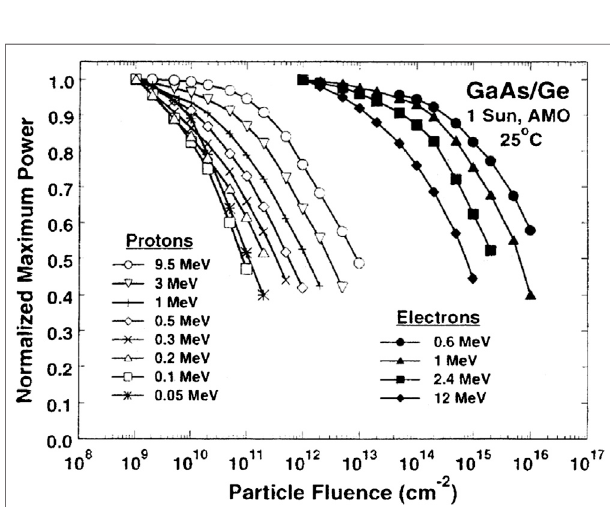
FIGURE 4 | Normalized P max degradation of GaAs/Ge solar cells irradiated by electrons and protons of different energy and with different particle fl uence